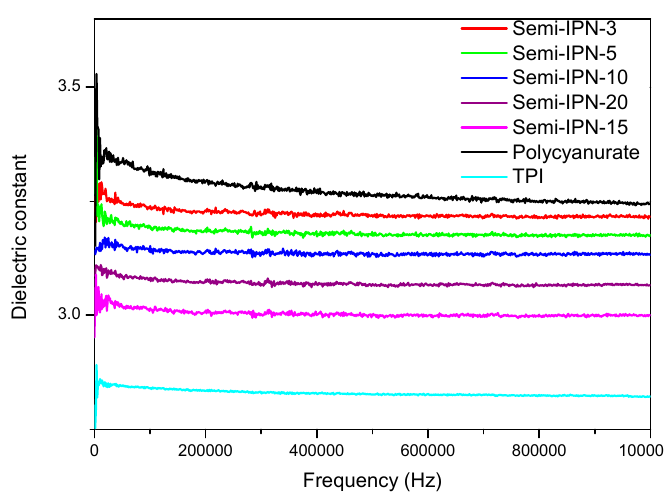
Figure 8. Dielectric constant as a function of frequency for TPI, polycyanurate, and semi-IPNs.